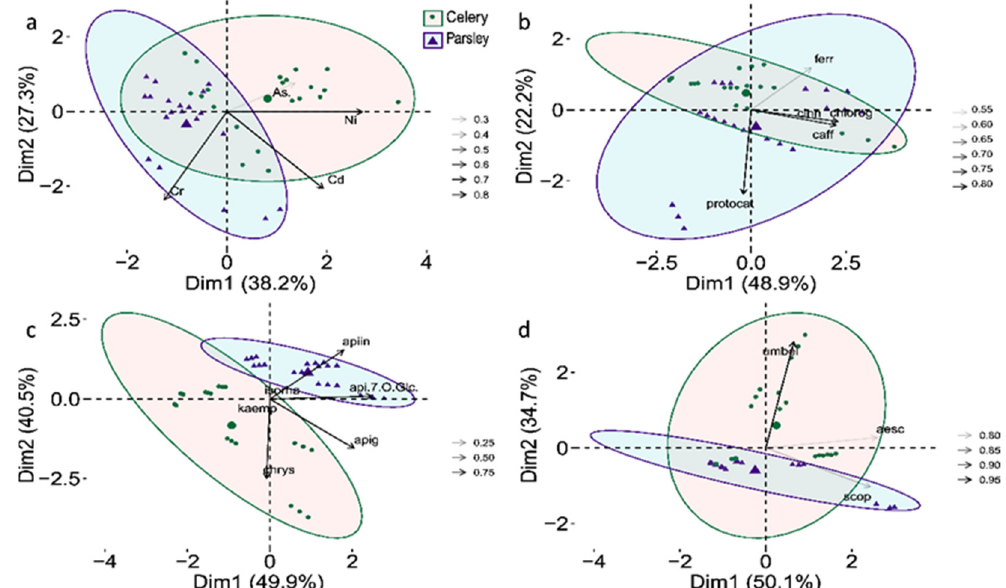
Figure 4. Multivariate analysis of trace elements content (TEs) and selected metabolites of celery and parsley; ( a )—biplot of TEs across the first two examined dimensions (PC); ( b )—biplot of phenolic acids, ( c )—biplot of flavonoids; ( d )—biplot of coumarins. Ellipses on biplot assume a multivariate normal distribution. Cos2 value is the square loadings for variables, presenting the quality of the representation of variables. Dim1 and Dim2 correspond to the first and second principal com-